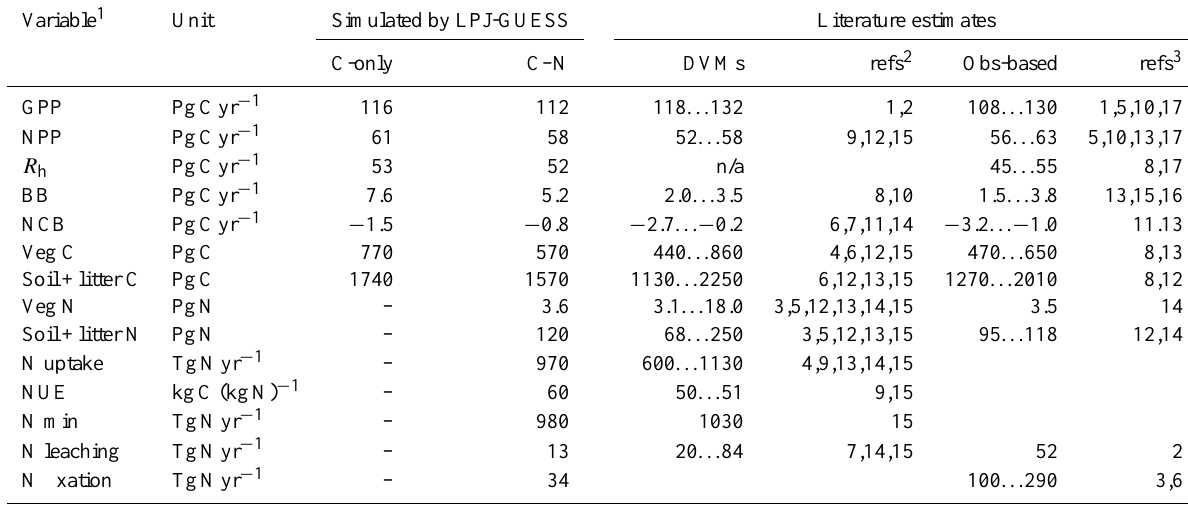
Table 1. Mean global C and N stocks and fluxes simulated for 1961–1990 in the global hindcast experiment, and according to literature